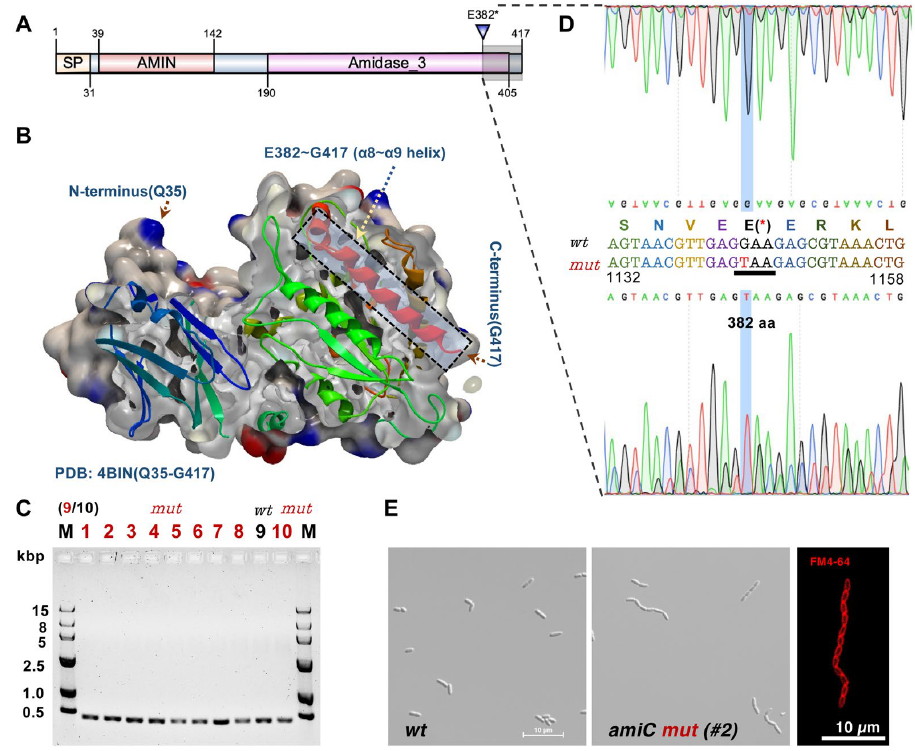
Figure 4. C-terminal deletion (E382*) of AmiC induces cells with a long-chain phenotype. ( A ) The domain information was depicted based on Pfam. SP: signal peptide; AMIN/Amidase_3: